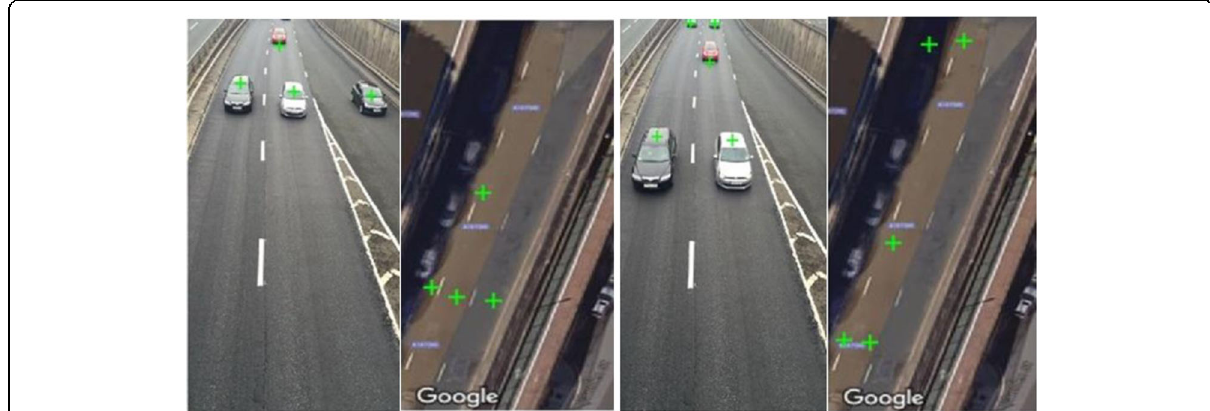
Fig. 17 Point correspondence between video and Google Map